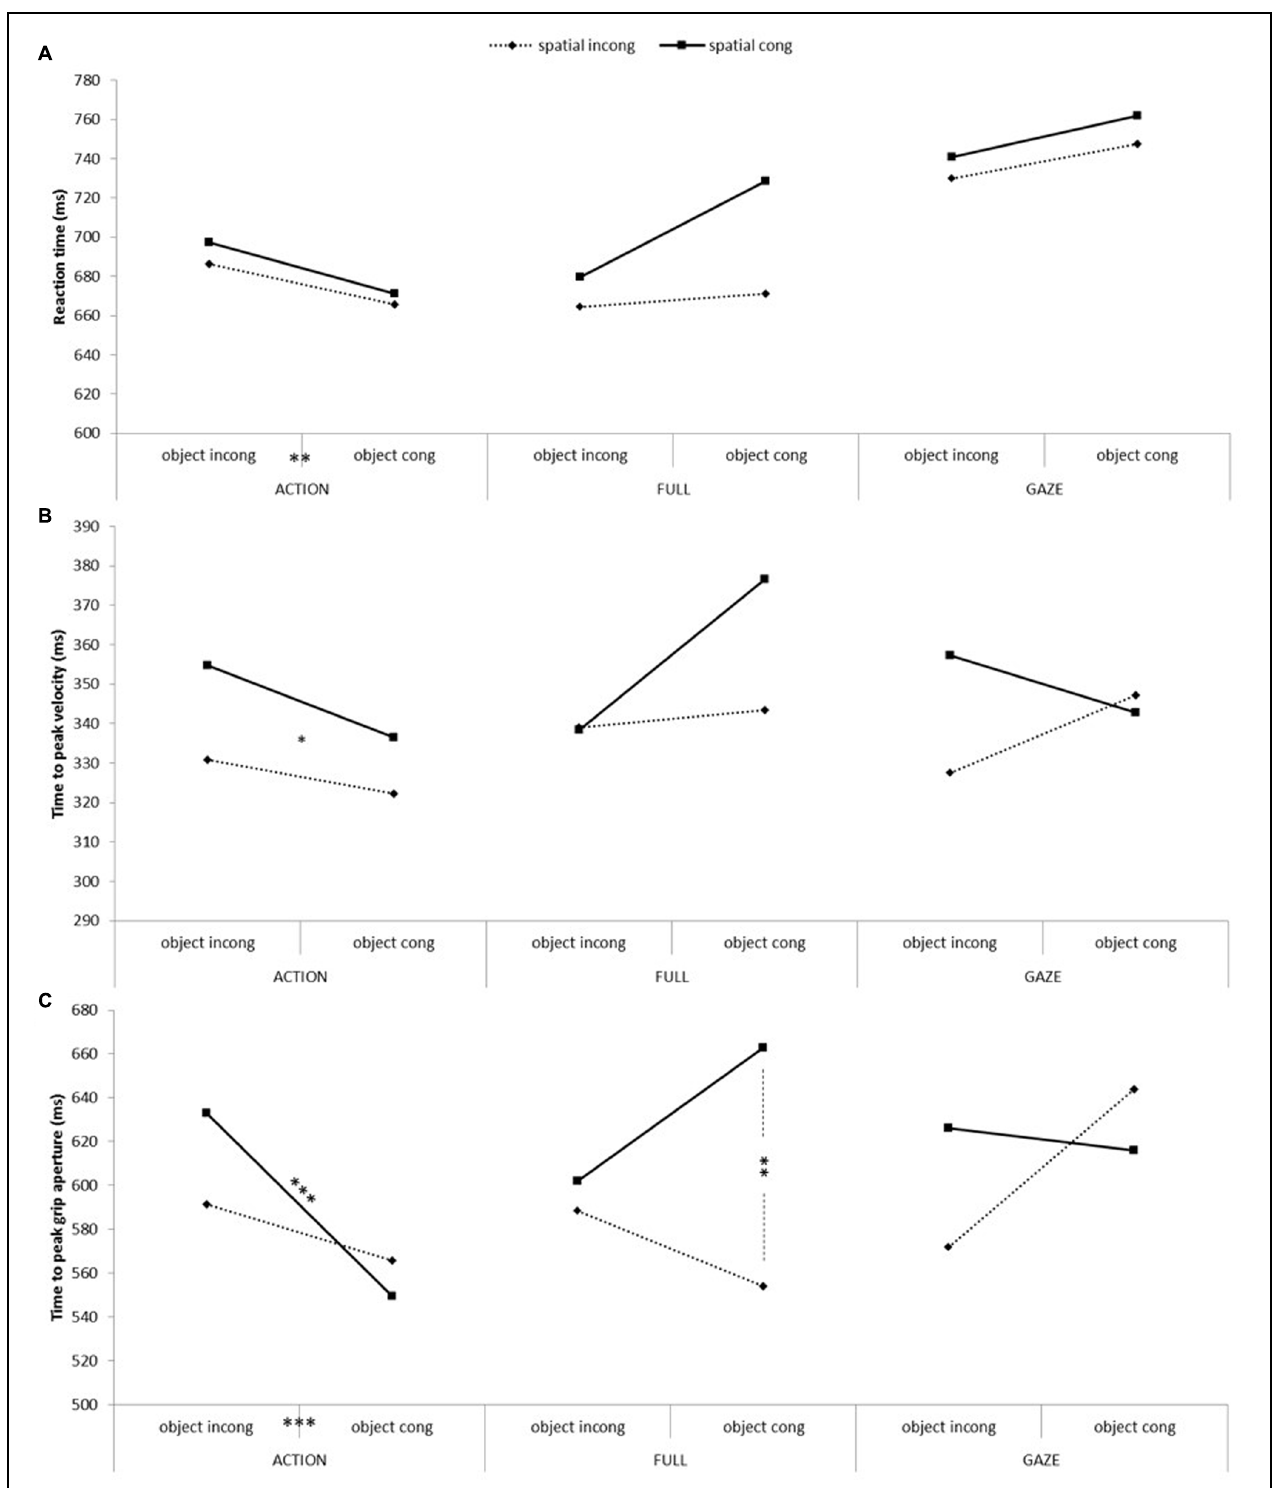
FIGURE 4 | Participants’ action measures as a function of conditions, object congruency and spatial congruency. From top to bottom: (A) Reaction time, (B) time to peak velocity and (C) time to peak grip aperture. The asterisks indicate a significant difference between experimental conditions ( ∗ p < 0.05; ∗∗ p < 0.01; ∗∗∗ p <